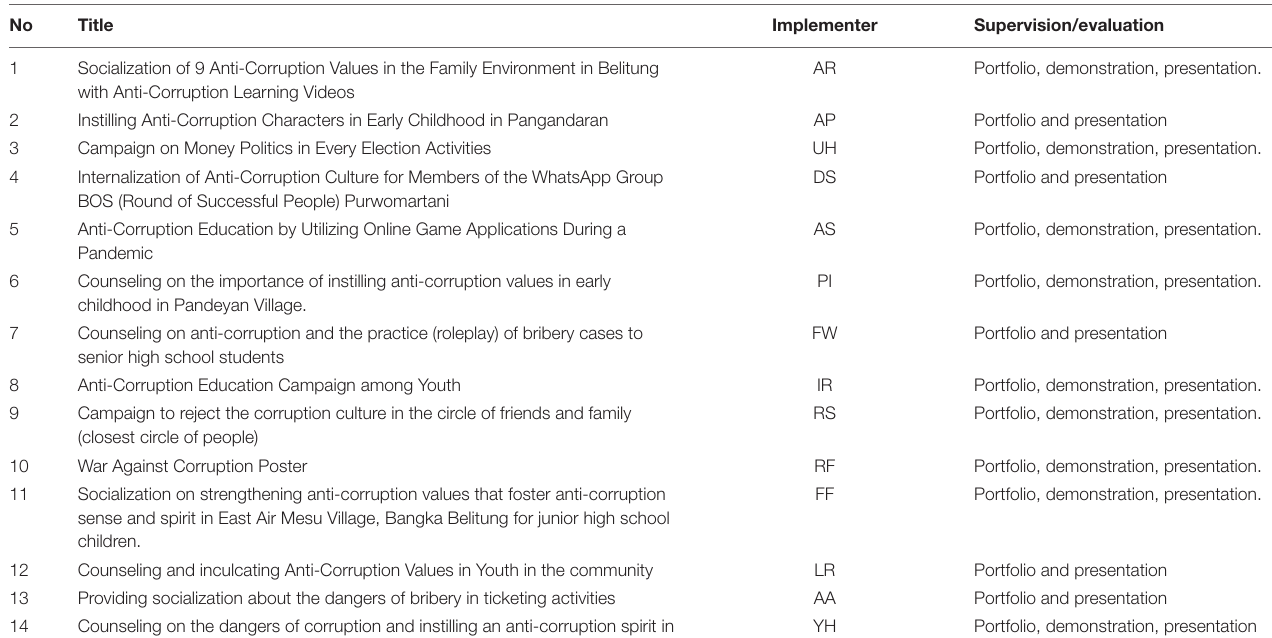
TABLE 2 | Title of the anti-corruption action plan for UAD PPKn study program